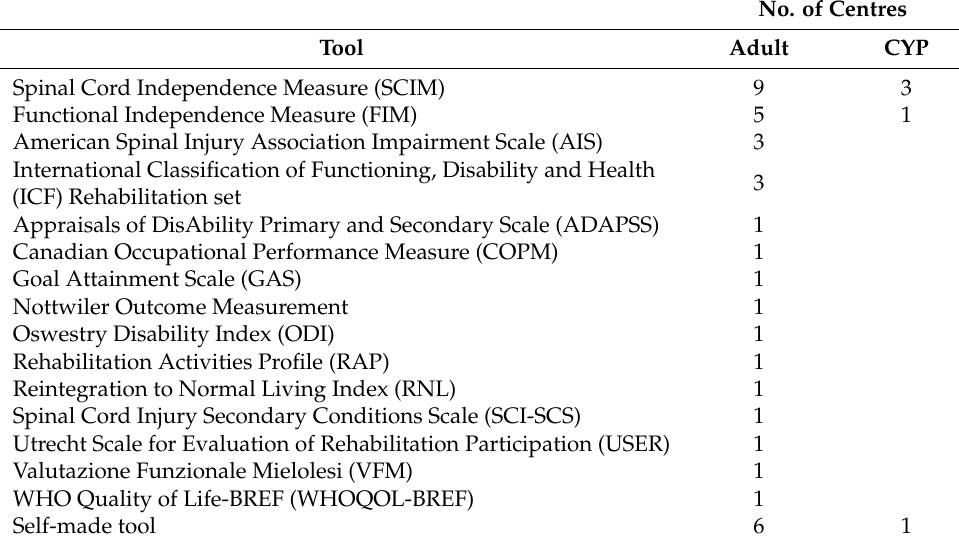
Table 9. Number of adult and CYP centres and the assessment tools used.